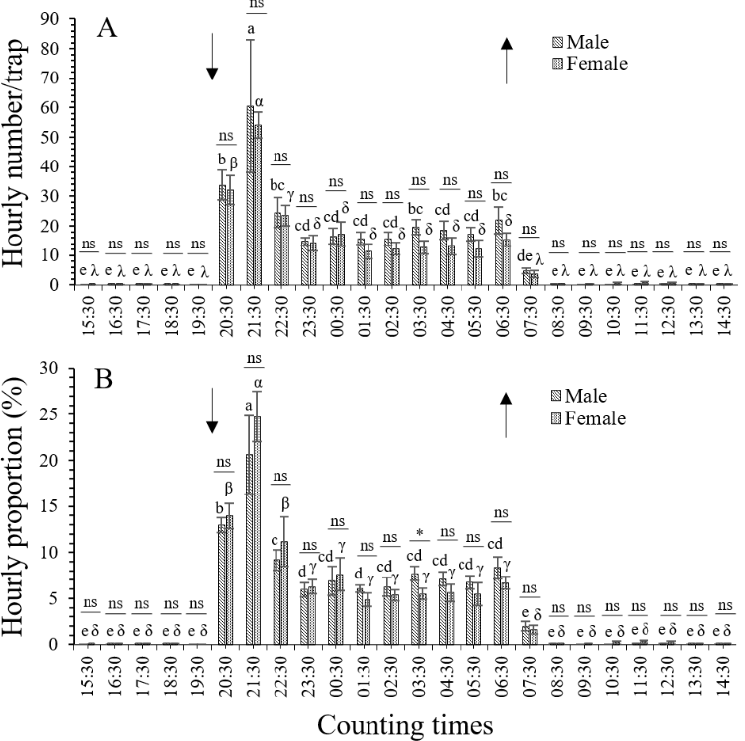
Figure 3. Hourly distributions of male and female Tuta absoluta adults flying toward UV light traps. Different lowercase Latin and Greek letters indicate significant differences among hourly periods for male and female adults, respectively, at the p < 0.05 significance level (one-way ANOVA and LSD test). The up and down arrows indicate sunrise and sunset, respectively. ( A ), hourly distribu- tion of numbers; ( B) , hourly distribution of proportions. The asterisk above the horizontal line indi- cates a significant difference between males and females during the same period at the p < 0.05 sig- nificance level (paired-sample t -test); ns, not significant.